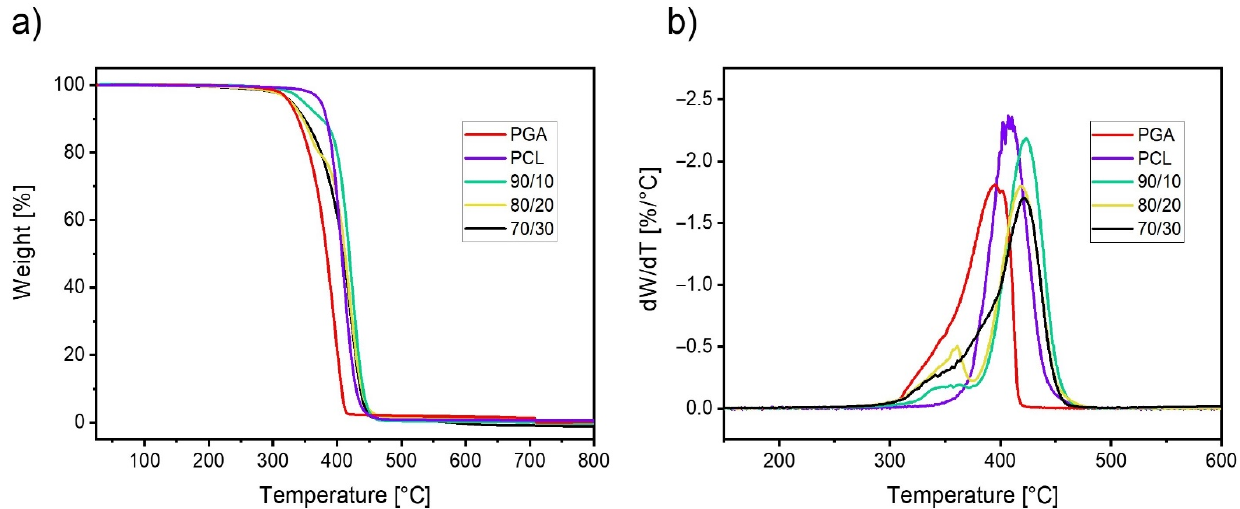
Figure 7. Mass loss versus temperature ( a ) and its derivative ( b ) for neat PCL, PGA, and their blends at the indicated compositions.